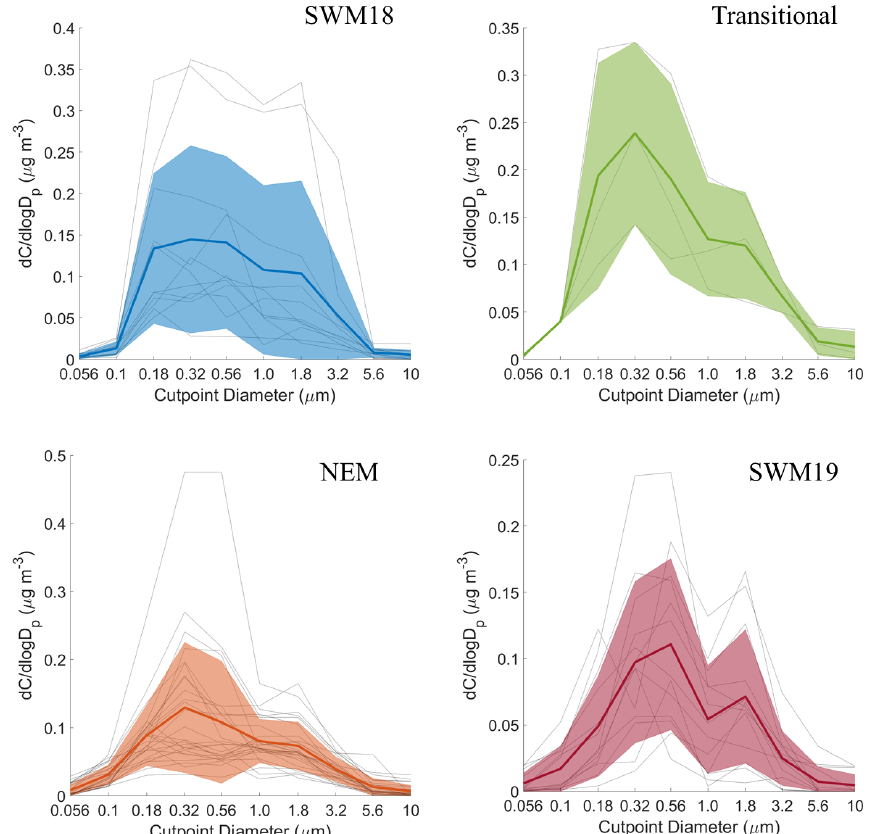
Figure 10. Same as Fig. 6 but for